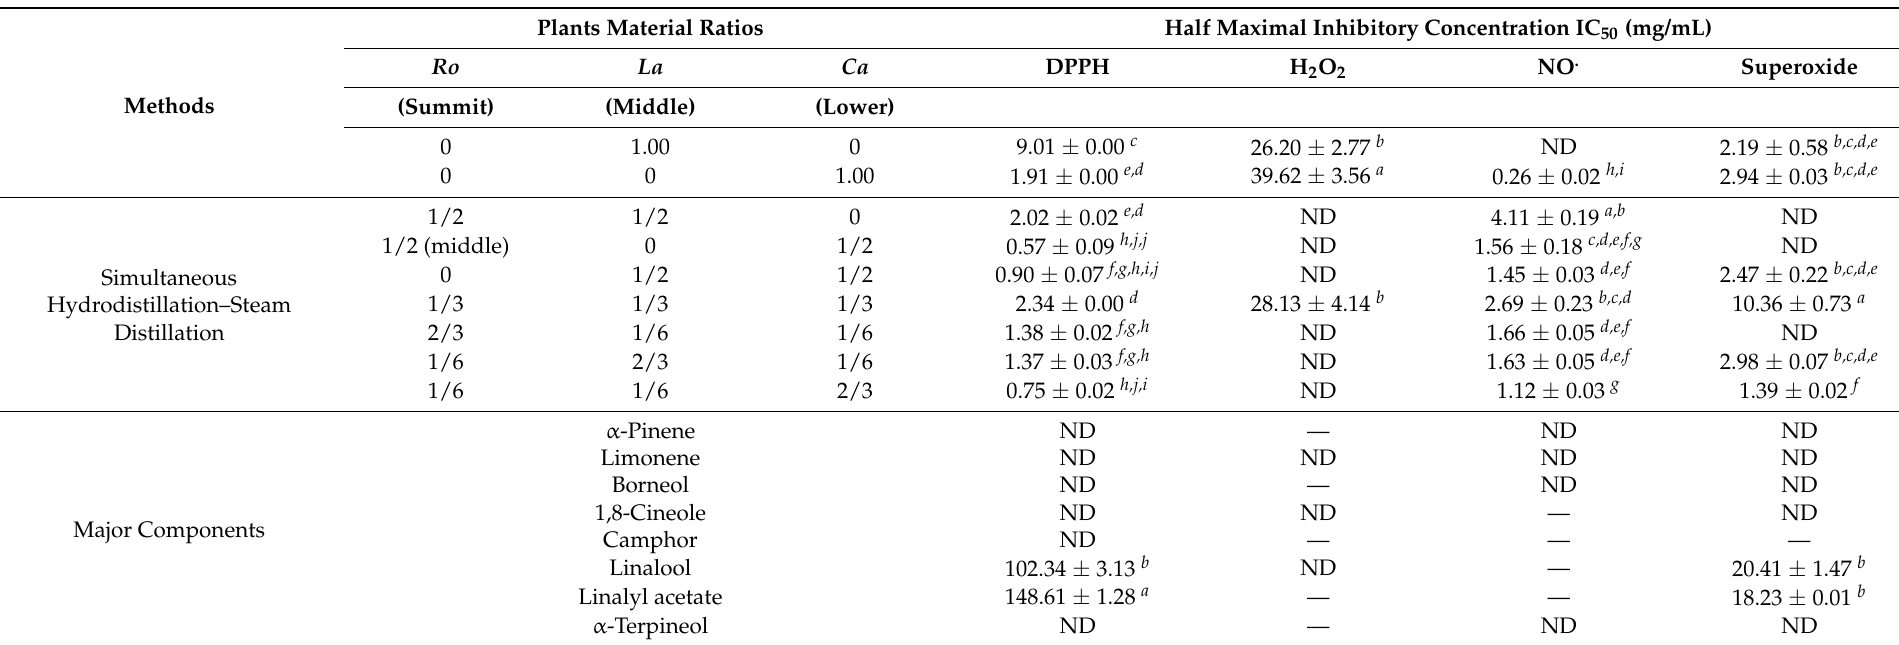
Table 3. Antioxidant activity of sample EOs extracted by hydrodistillation and simultaneous hydrodistillation–steam